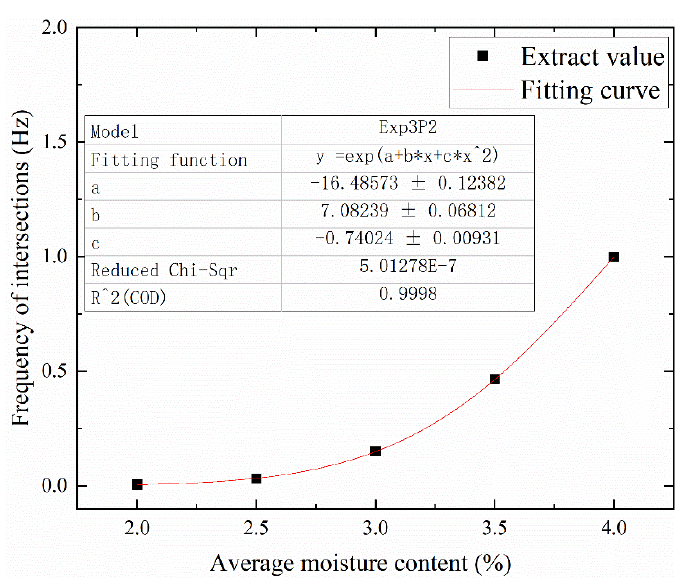
Figure 16. Relationship between tan δ and ω .